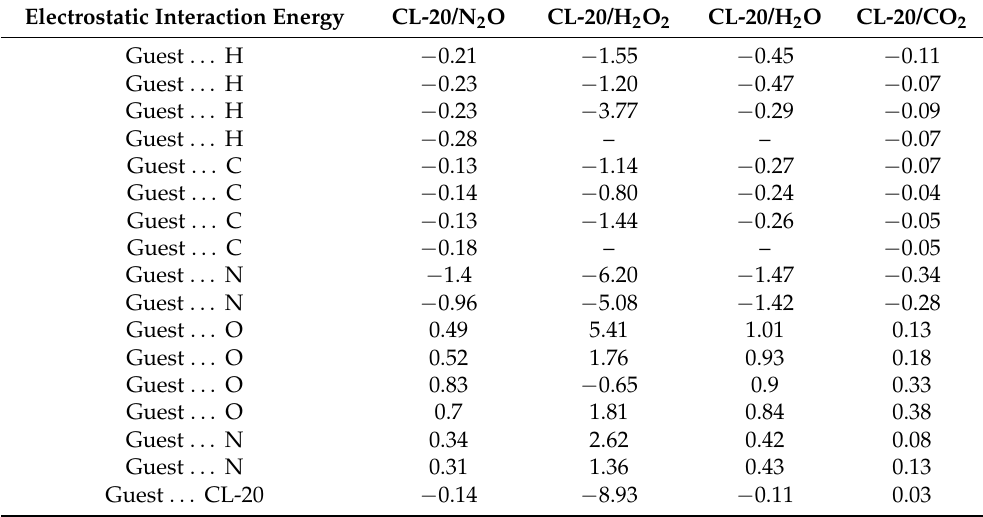
Table 1. The electrostatic interaction energy (kJ·mol − 1 ) between the two fragments of four host–guest explosives.